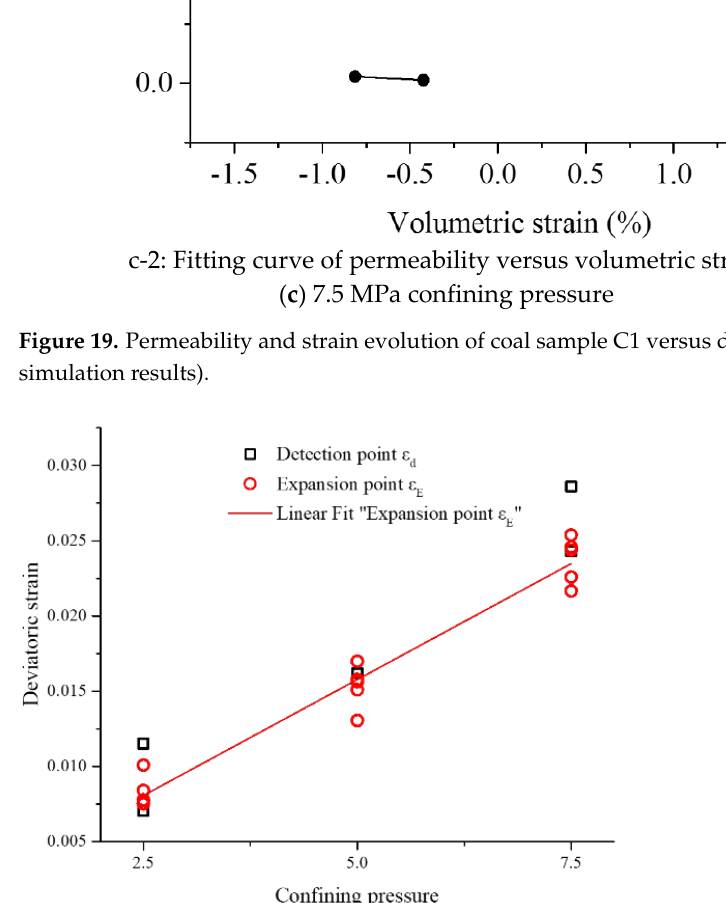
Figure 21. Permeability versus volumetric strain for different confining pressures obtained from numerical simulations (regression curves refer to values after the expansion point). The numerical simulations show some remarkable scatter due to the heterogeneity of the samples, although the general trend becomes obvious (see Figure 21). The obtained fitting curves may not be able to represent the behavior of individual samples, but deliver reasonable overall trends. The sample volume at the expansion point is much lower with